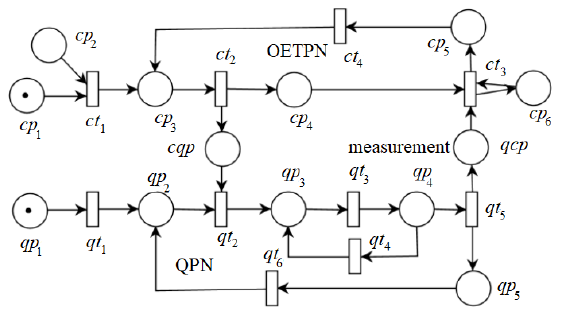
Figure 15. Classic-quantum application